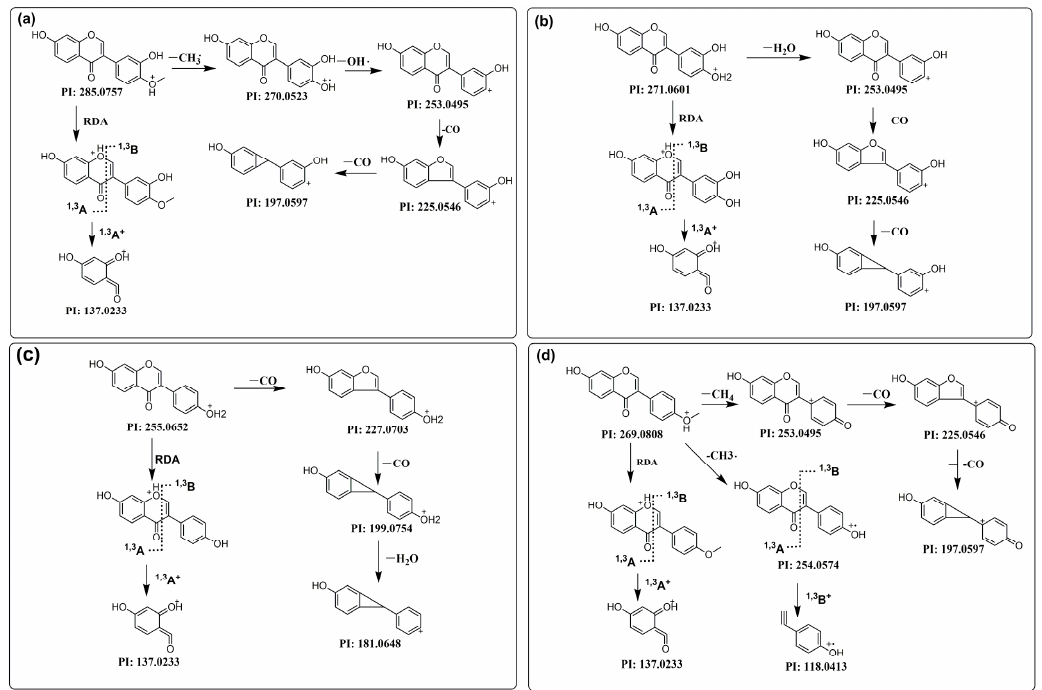
Figure 3. Proposed fragmentation pathways of calycosin ( a ), 7,3 ′ ,4 ′ -trihydroxyisoflavone ( b ), daidzein ( c ), and formononetin ( d ).